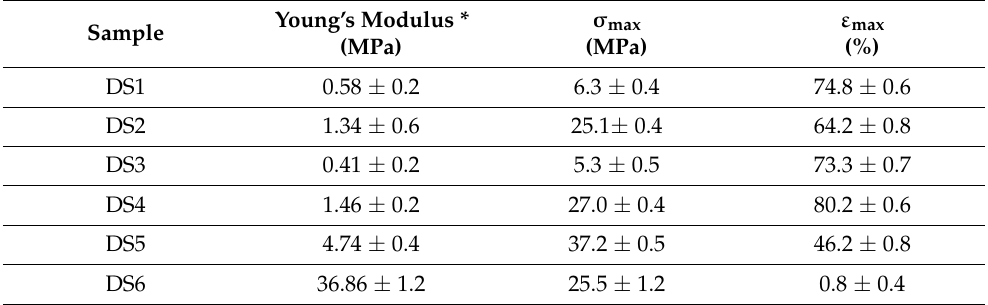
Table 5. Tensile test results for the nanocomposite films.